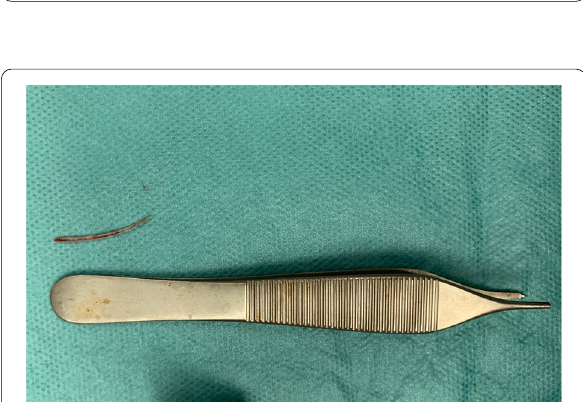
Fig. 3 CT scan neck: sagittal view of the foreign body within the fluid collection